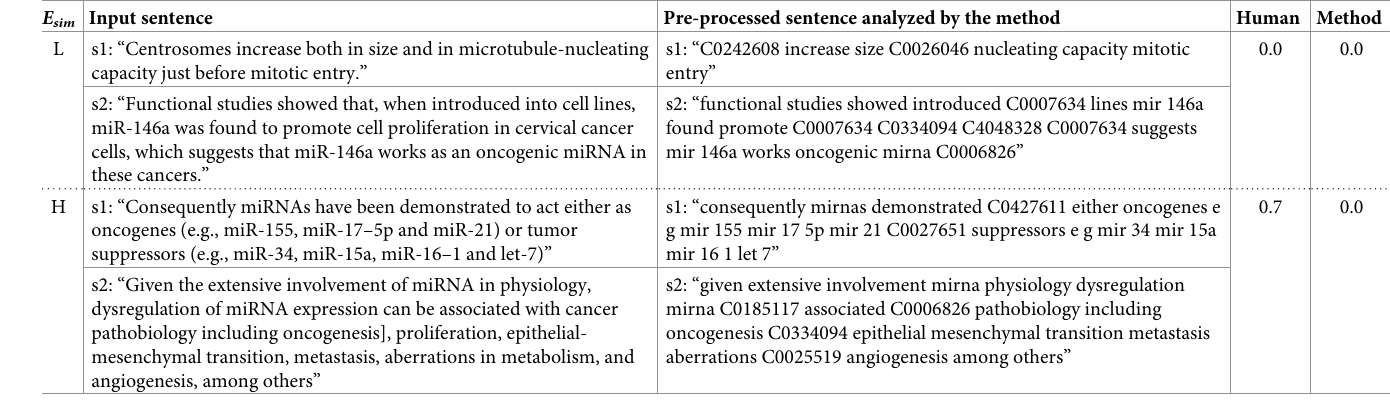
Table 13. Raw and pre-processed sentence pairs obtaining the lowest and highest similarity error E ity score (Human) and normalized similarity value (Method) estimated by the LiBlock (M4) method for the raw and pre-processed sentence pairs with the lowest (L) and highest (H) similarity error E . sim